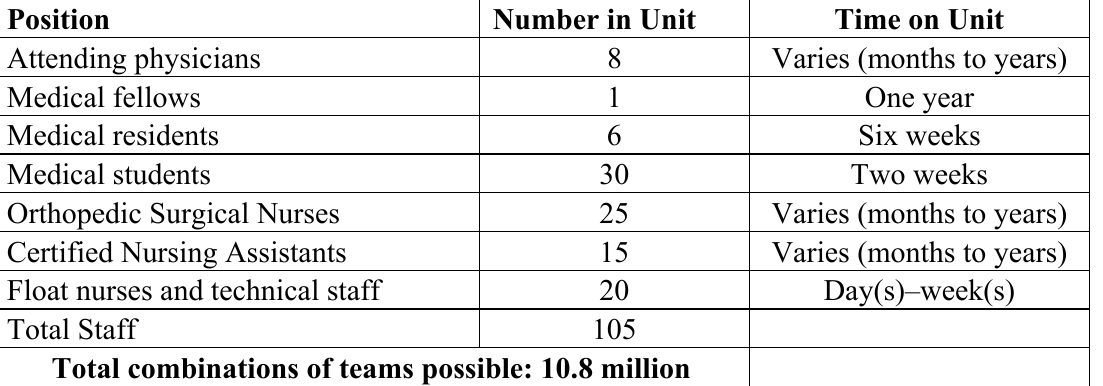
Table 2. Example of a microsystem team: Adult orthopedic surgery unit at a university hospital.